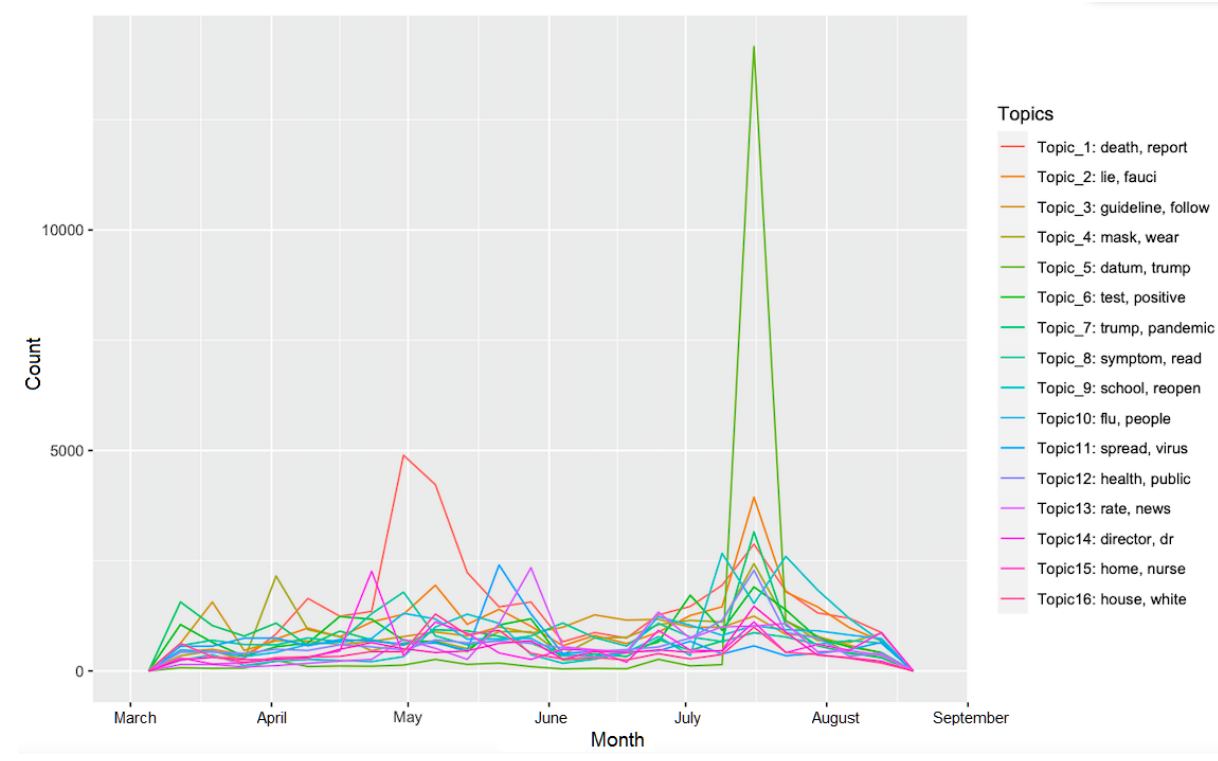
Figure 2. Weekly frequency of each topic on Twitter, from March 11 to August 14,